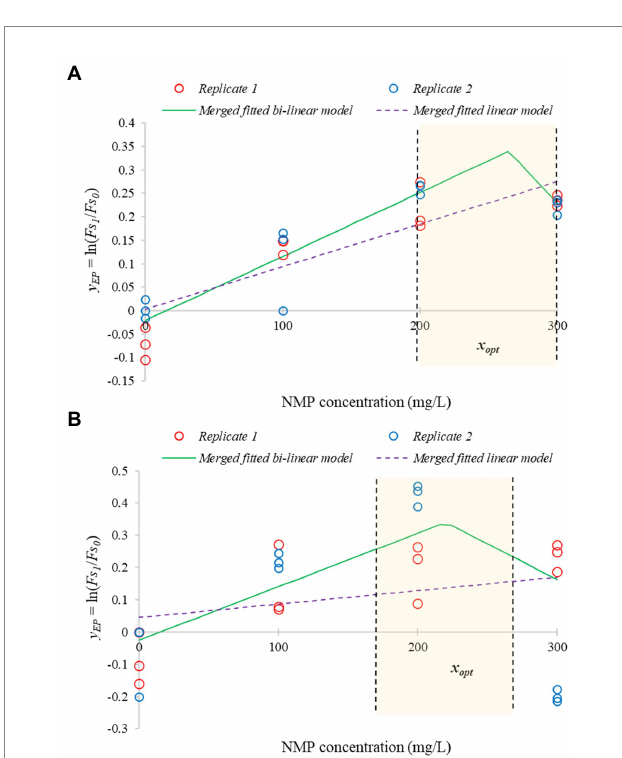
FIGURE 9 Bi-linear secondary models to describe the efflux inhibition by NMP, a synthetic inhibitor. The fit determines the range of optimum NMP concentration. The bi-linear function (continuous green lines) significantly improves the fit compared to the linear function (dashed purple lines). The figure is based on two independent replicates using stationary phase cultures of E. coli VF 3584 (A) and E. coli ATCC 11229 (B) .